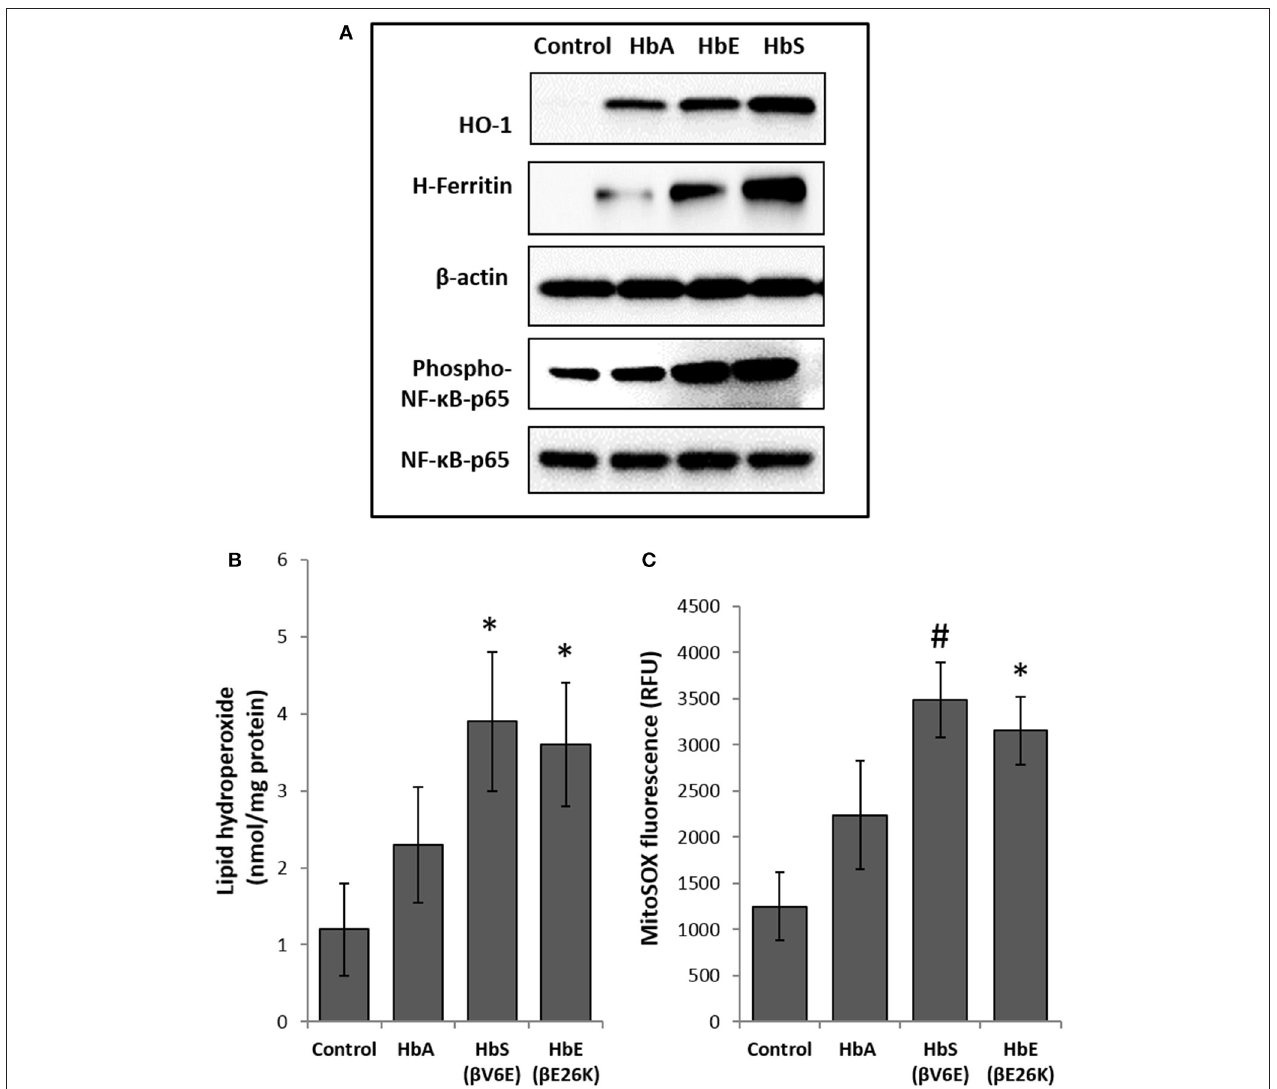
FIGURE 1 | Effect of normal and mutant human hemoglobins on human pulmonary arterial endothelial cells (HPAEC). (A) HPAEC were exposed to ferrous forms of either HbA, HbS, or HbE at equimolar concentration (100 µ M) for 12h. Cell lysates were immunoblotted with primary antibodies against HO-1, H-ferritin, phospho-NF- κ B-p65 and NF- κ B-p65 proteins. Equal loading was confirmed by re-probing the blots against β -actin. Blots are representative of three independent experiments. (B) Levels of lipid hydroperoxides and (C) mitochondrial superoxide radical generation was measured in HPAEC following exposure to different Hb proteins as described in the methods section ( N = 3). Values from different treatment groups were compared using Mann-Whitney U -test. * P < 0.05 vs. untreated control, # P < 0.001 vs. untreated